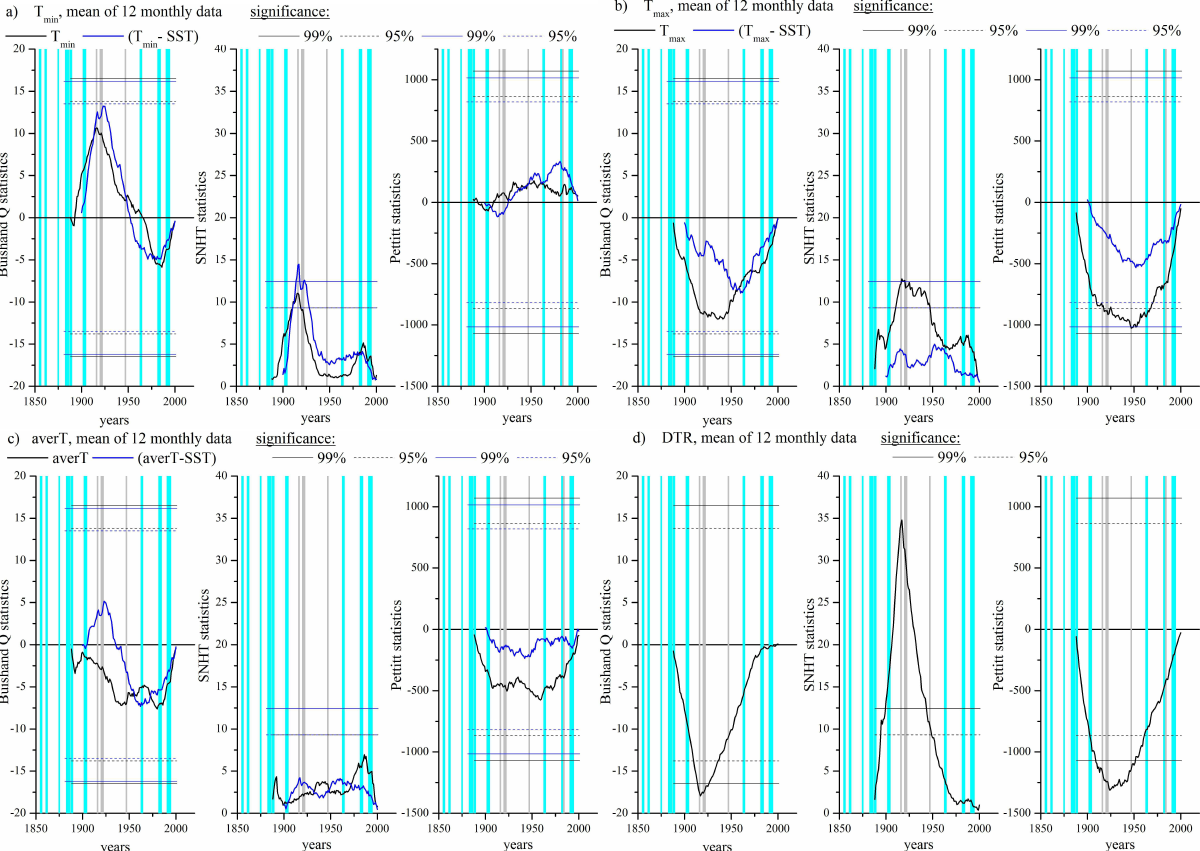
Figure 5. Porto: average of 12 monthly series of Buishand Q test (left panels), SNHT (middle panels) and Pettitt tests (right panels) statistics of T min (a) , T max (b) , T aver (c) and DTR (d) . Statistics of temperature series are shown in black, statistics of di ff erences between temperature and SST series are shown in blue. Solid and dashed horizontal lines show probability levels of 99% and 95%, respectively. Grey vertical lines show known dates of instrumental changes, cyan broad vertical lines show periods of strong volcanic